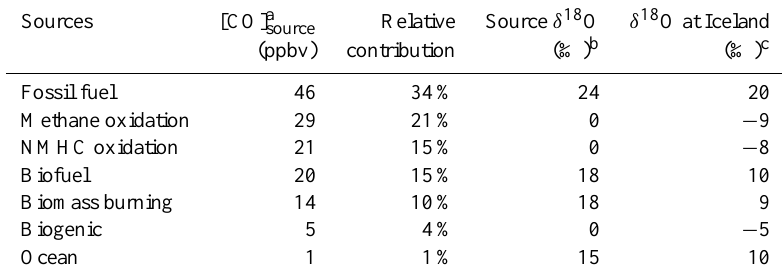
Table 1. Atmospheric CO source contributions and δ 18 O at Iceland in Jan 1997–Dec 2004. Sources [CO] a source Relative Source δ 18 O δ 18 O at Iceland (ppbv) contribution Fossil fuel 46 34% 24 20 Methane oxidation 29 21% 0 − 9 NMHC oxidation 21 15% 0 − 8 Biofuel 20 15% Biomass burning 14 10% 9 Biogenic 5 4% 0 − 5 Ocean 1 1% 15